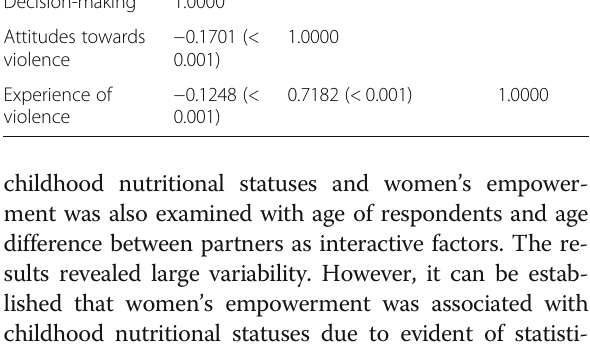
Table 6 Fully adjusted Model and Model with Interaction